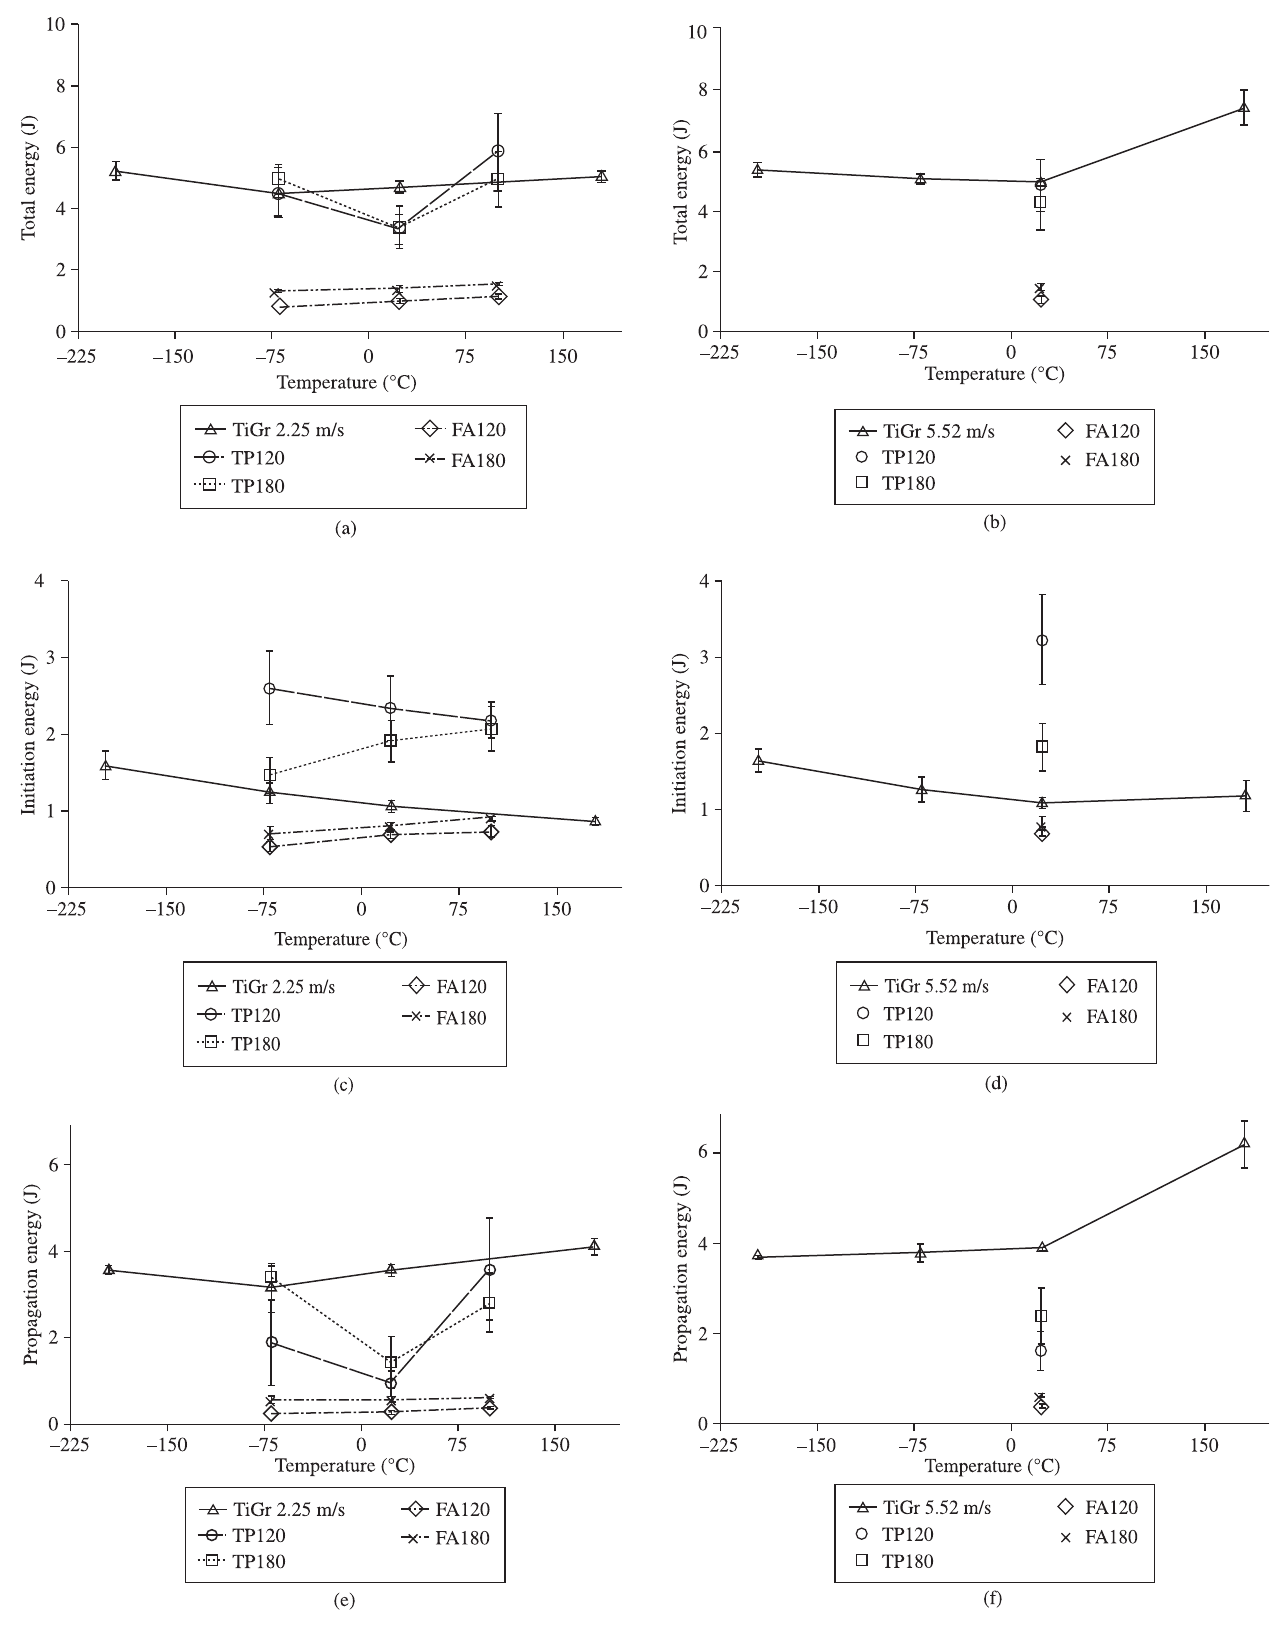
Figure 4. Specific impact toughness results for the studied laminates at different test temperatures and applied loading rates: a) and b) Total absorbed energy - E c) and d) Initiation energy - E